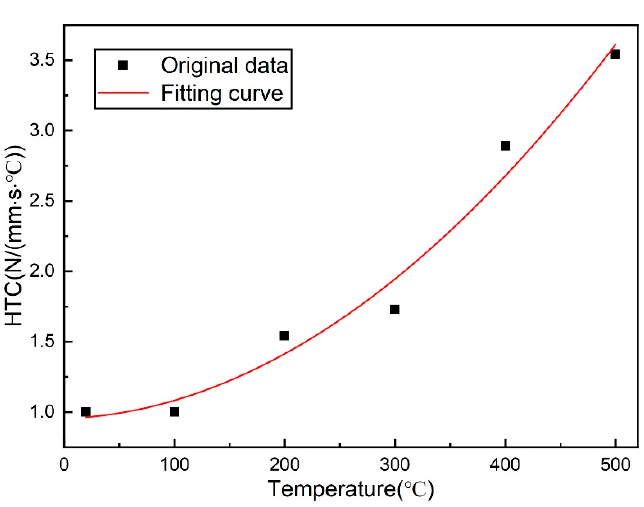
Figure 8. Fitting curve of heat transfer coefficient in the heating process. Table 5. The temperature data of the heating progress.